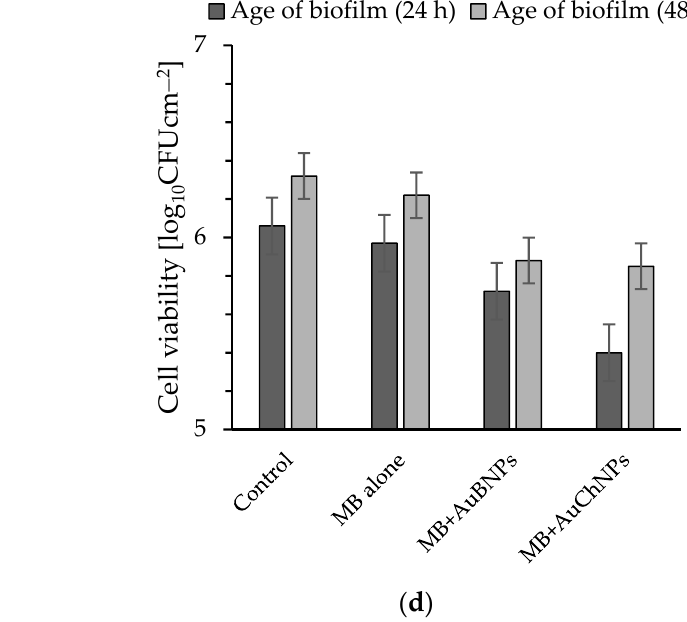
Figure 2. Effect of MB alone, MB + AuBNPs, and MB+AuChNPs on the viability of biofilm formed on the surface of glass discs by S. aureus 3374 ( a ); S. aureus 3375 ( b ); S. aureus 3515 ( c ); S. aureus 3690 ( d ) after exposure to laser light for 30 min (energy fluence was 189 J cm − 2 ). Average ±SD of three independent experiments is shown; in all groups, p < 0.05. Age of biofilm: (24 h) = biofilm formed on the glass surface within 24 h; (48 h) = biofilm formed on the glass surface within 48 h.